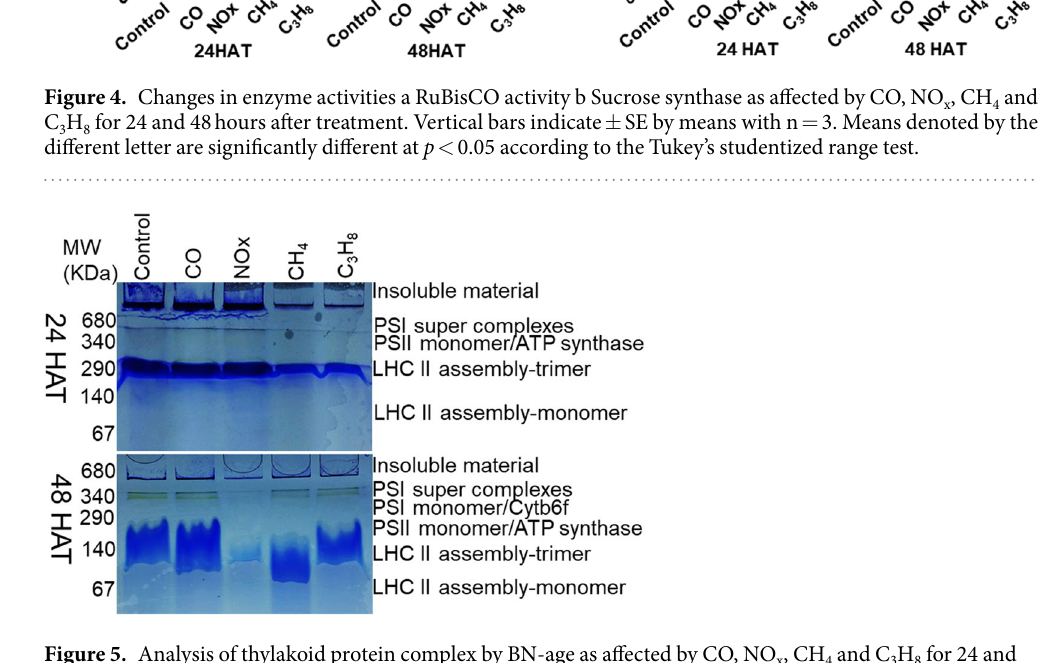
Net photosynthesis Fv/Fm Rubisco Total chlorophyll